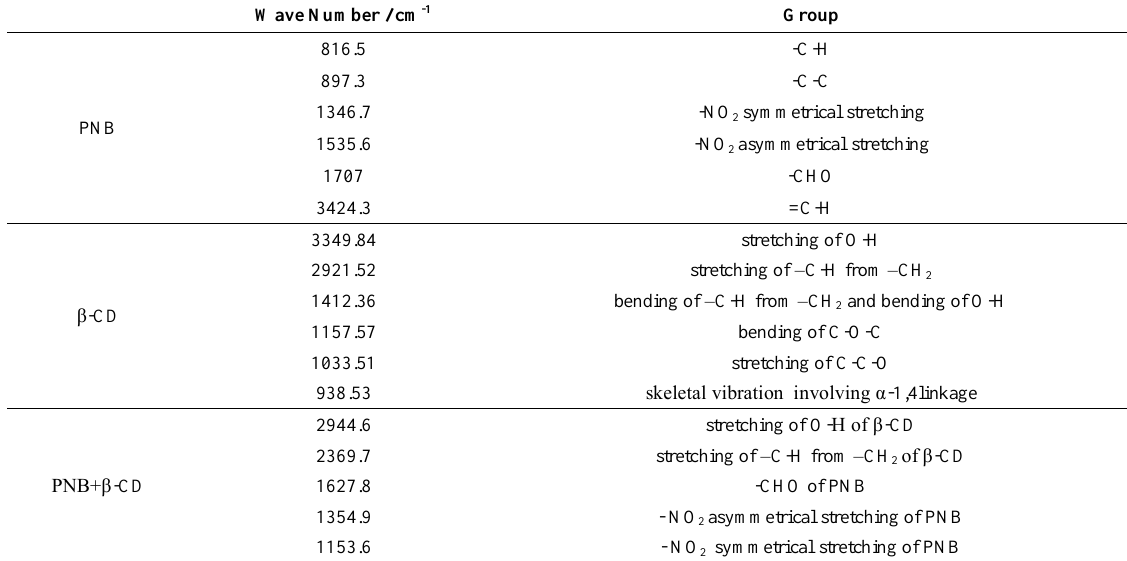
Figure 9. FT-IR spectra of β-CD, PNB, PNB- β-CD inclusion complex. Table 5. Frequencies at FTIR spectra of PNB, β-CD and solid inclusion